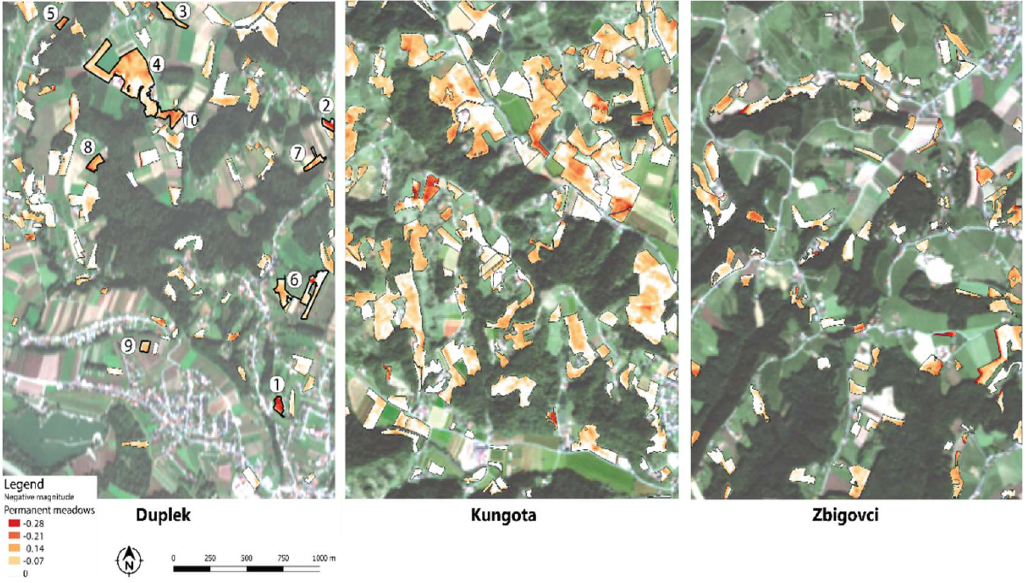
Figure 5. The magnitudes of detected changes on permanent meadows obtained with the BFAST Monitor method for the three study areas. From the selection of all detected anomaly pixels, only those objects (parcels) with stronger share of negative magnitude values (dark red) were selected as candidates for the land use anomaly sample and further verification.